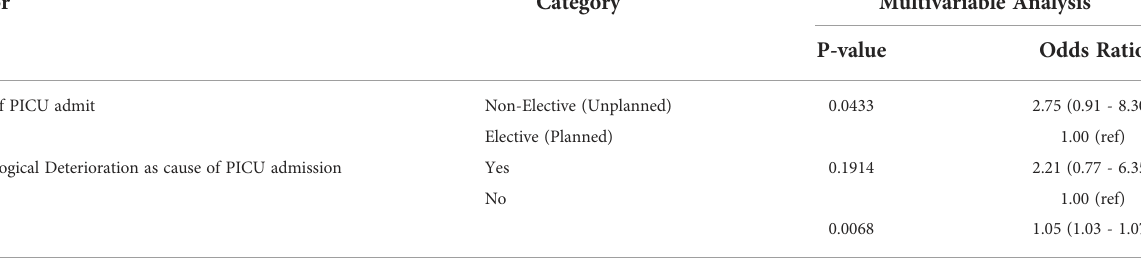
TABLE 3 Multivariate analysis of Risk Factors for Mortality (GEE Model) among all admissions (including PIM2).